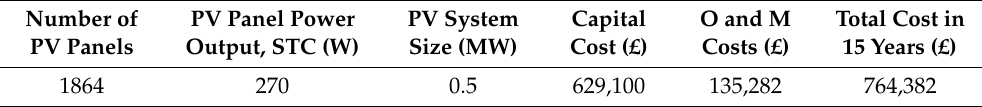
Table 5. Total cost of PV installation for a lifetime of 15 years.